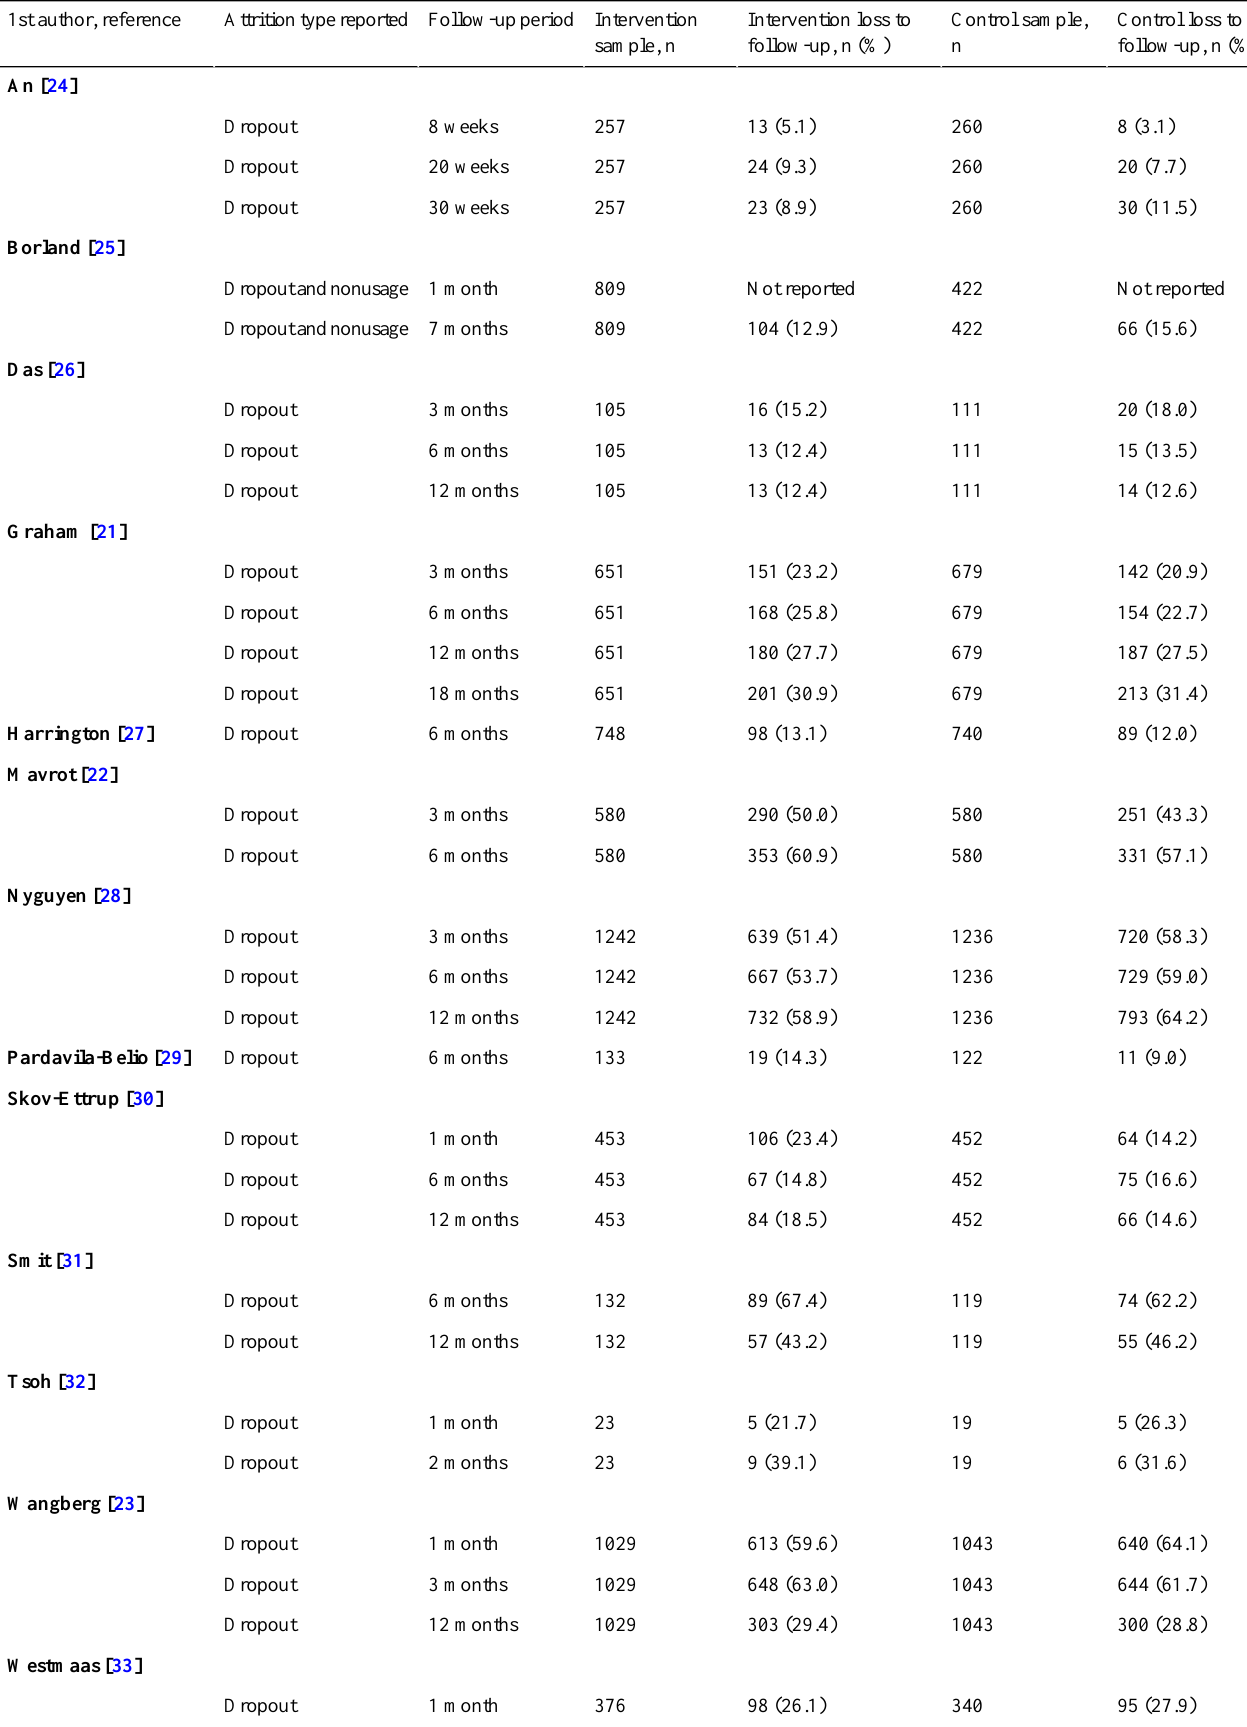
Table 1. Summary of attrition (n=13).